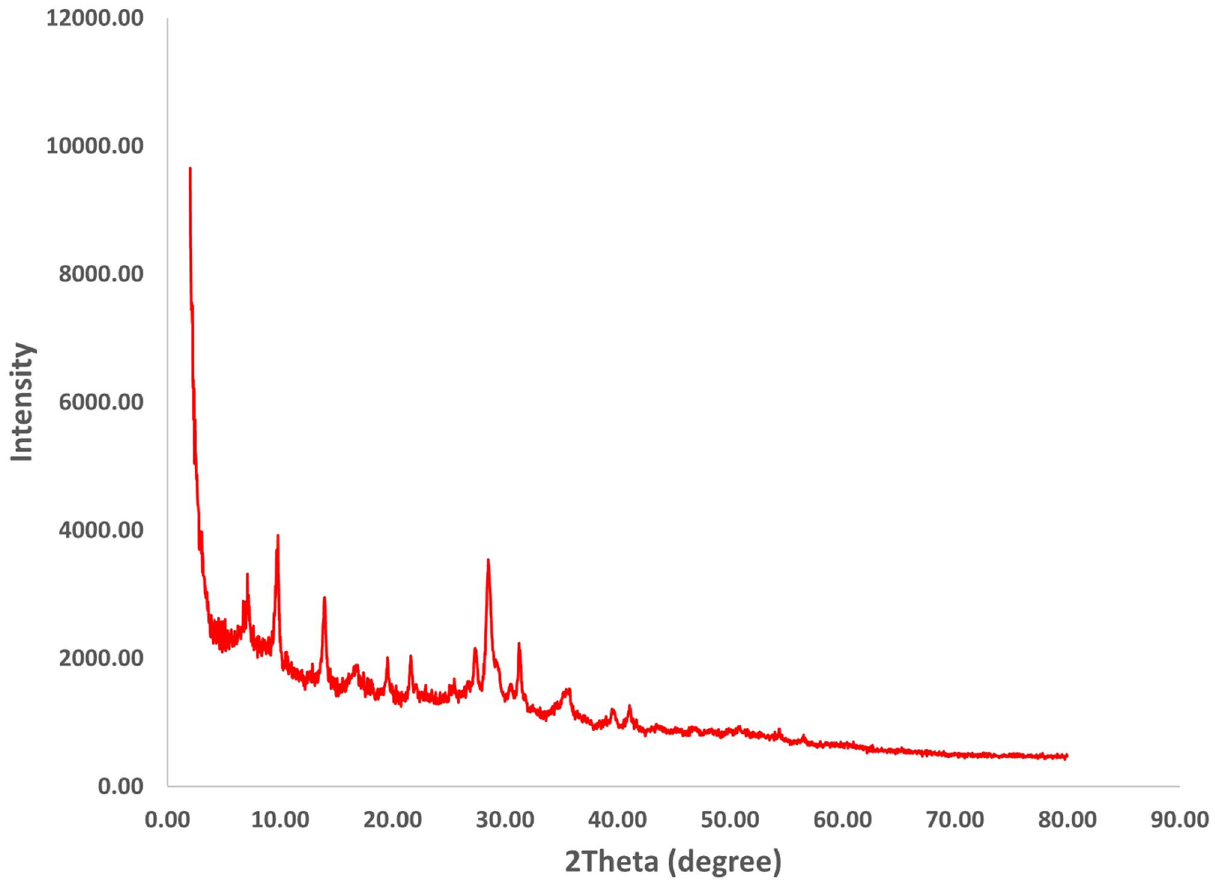
Figure 5. XRD pattern of Fe 3 O 4